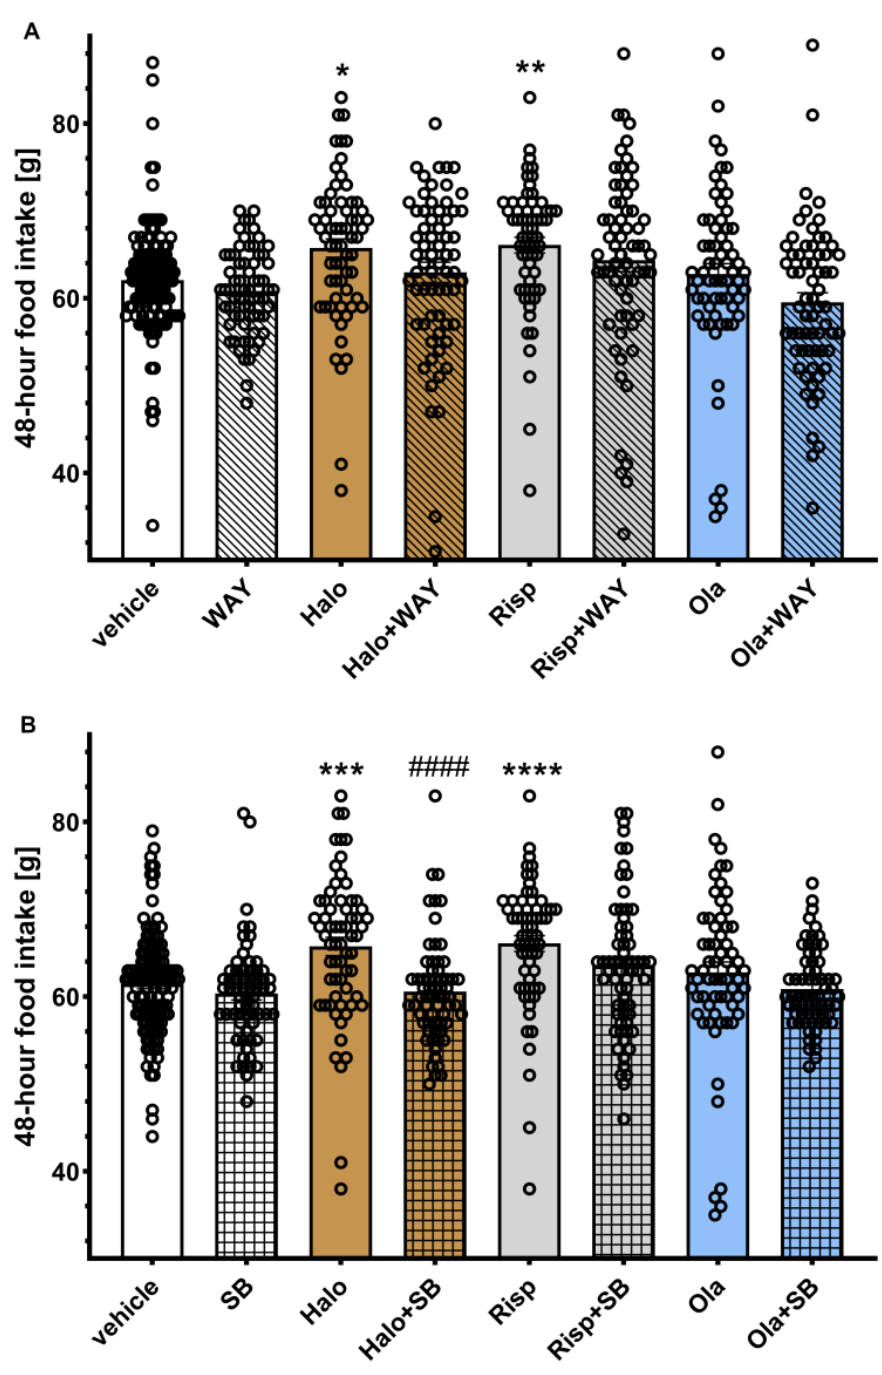
Figure 2. Effects of haloperidol, risperidone, olanzapine, WAY-181187 ( A ) and SB-742457 ( B ), given alone and in combinations, on average 48-hour food intake in rats. The average 48-hour intake in each group was calculated from all measurements taken throughout the experiment. The results are presented as mean ± SEM; n = 9–10. * p < 0.05, ** p < 0.01, *** p < 0.001, **** p < 0.0001 versus respective vehicle-treated group; #### p < 0.0001 versus the respective APD-treated group (two-way ANOVA followed by Bonferroni’s post hoc test). Halo, haloperidol 0.5 mg/kg; Risp, risperidone 0.5 mg/kg; Ola, olanzapine 5 mg/kg; WAY, WAY-181187 3 mg/kg; SB, SB-742457 3 mg/kg.